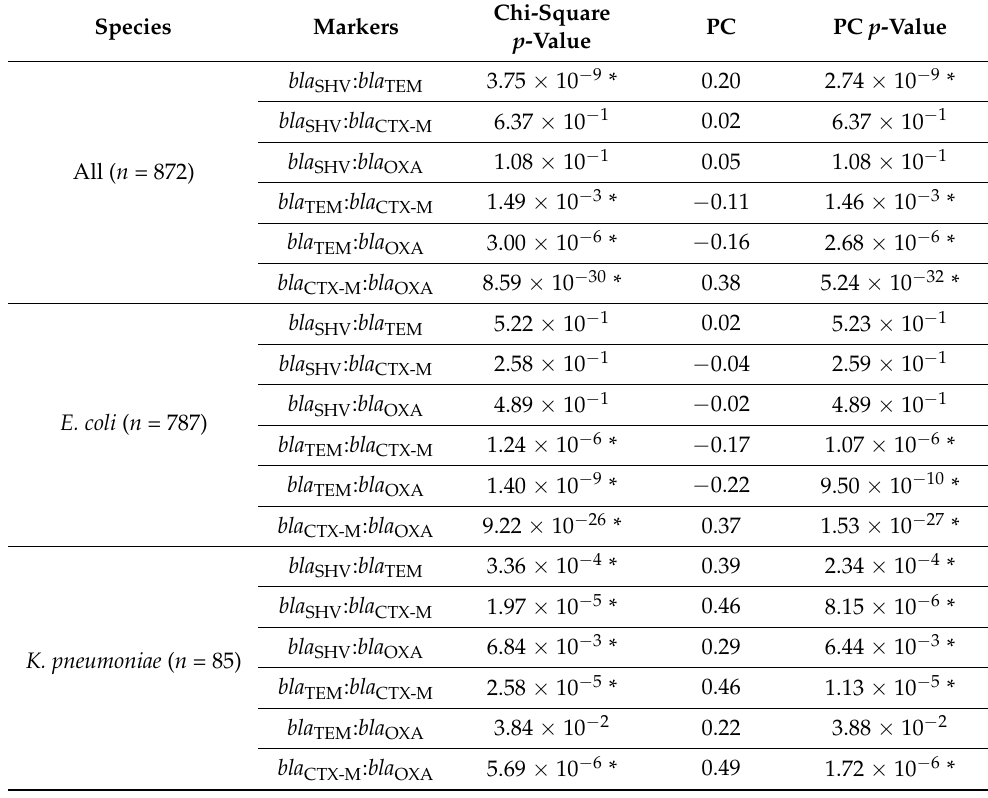
Table 2. Linkage analysis summary for DHMMC isolates. The p -value for a chi-square test for linkage, the phi coefficient, and the associated p -value are presented for each resistance marker pair comparison. The number of isolates for each species is given in parenthesis. An asterisk (*) indicates a statistically significant comparison after the FDR-controlling procedure ( q * = 0.025) for both the chi-square test and the phi coefficient.